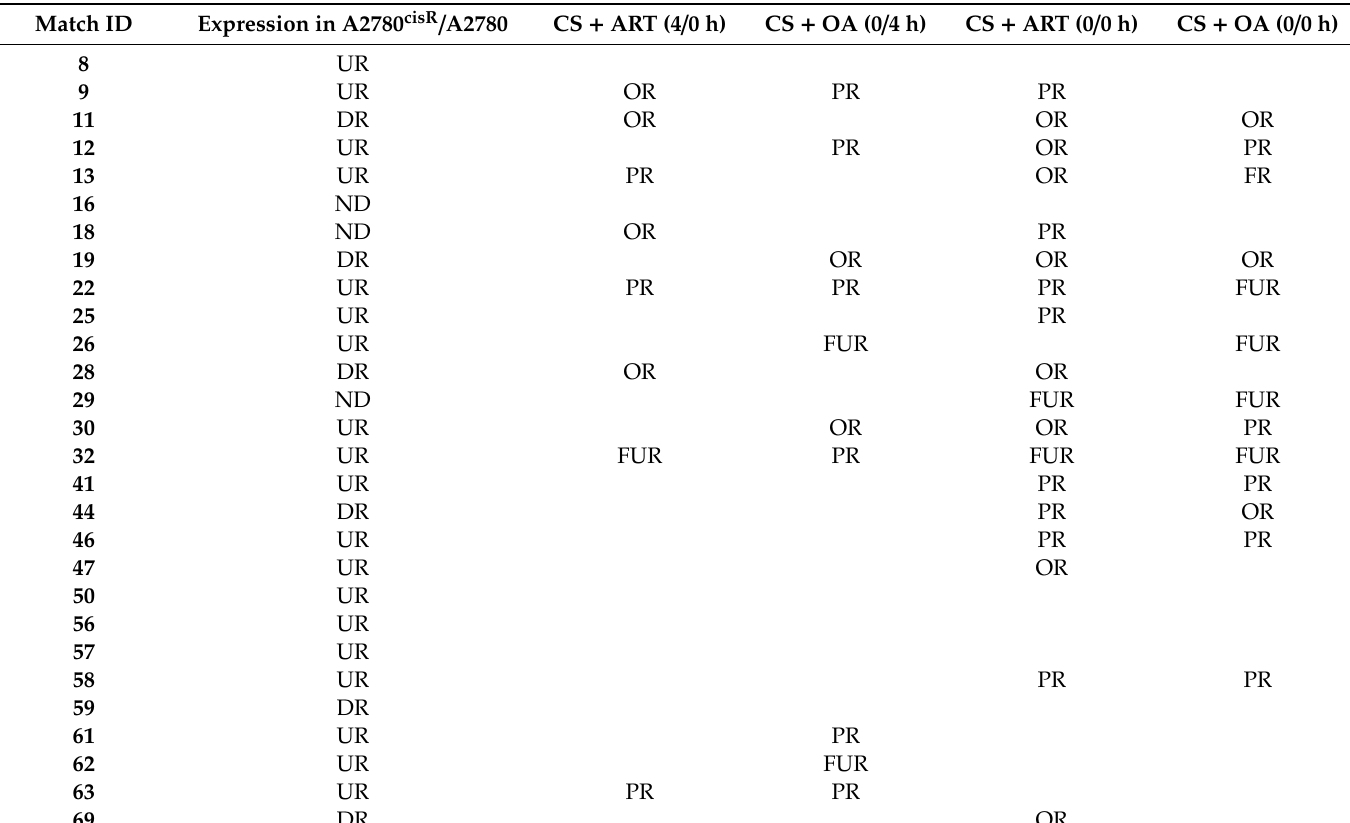
Table 8. List of protein expressions in, A2780 cisR compared to A2780 using A2780 cisR as